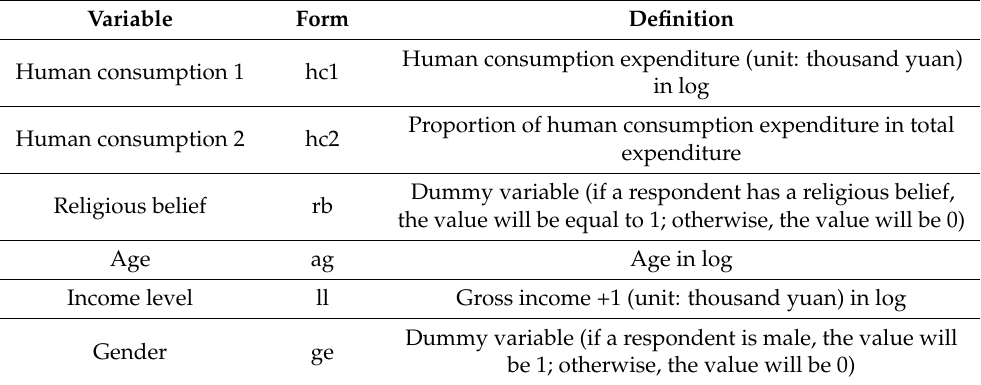
Table 1. Results of variable